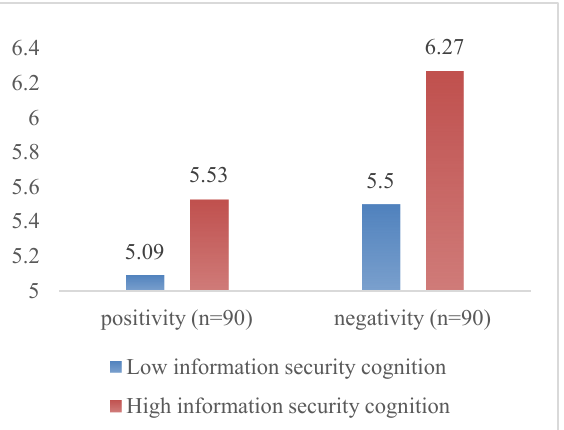
Figure 6. Comparison of the Mean Value of the Nature of the Framework and the Information Security Cognition.